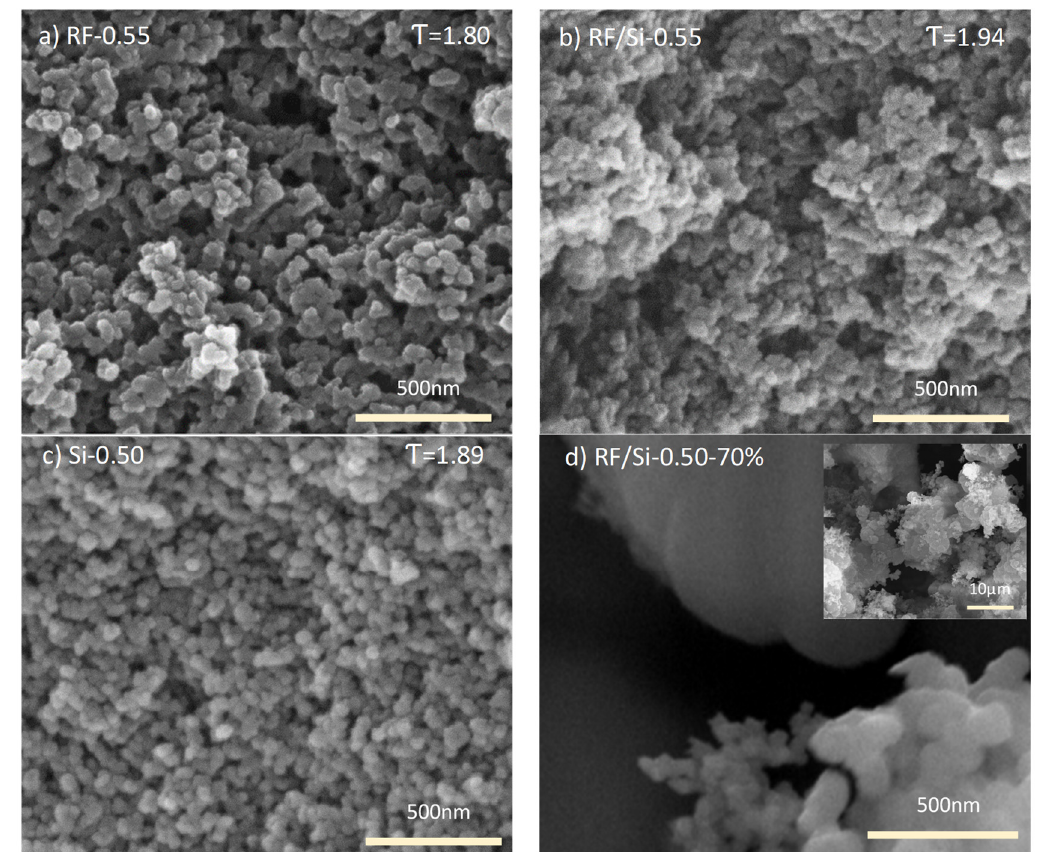
Figure 6. SEM micrographs of the different synthesized xerogels: ( a ) RF-0.55, ( b ) RF/Si-0.55, ( c ) Si- 0.50 and ( d ) RF/Si-0.50–70%.